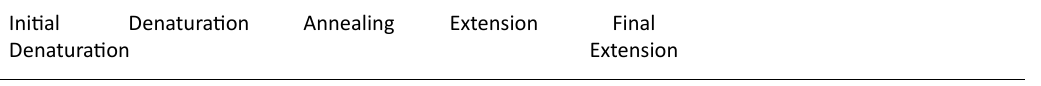
table 3. PCR program used for Multiplex PCR Initial Denaturation